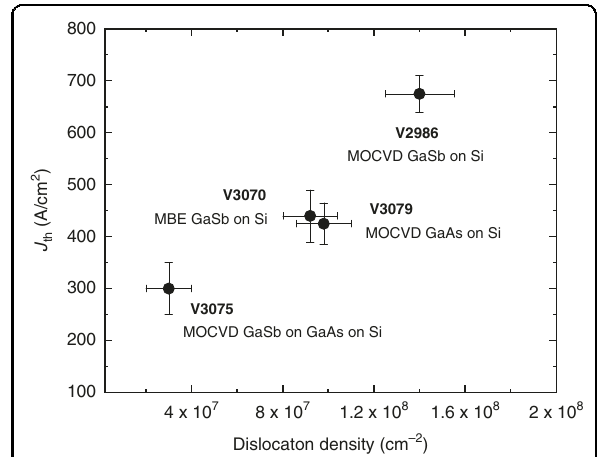
Fig. 11 Evolution of the threshold current density measured at room temperature for GaSb DLs grown on various III – V-on-Si templates, as a function of the threading dislocation density estimated by atomic force microscopy. The nature of the buffer layer is indicated next to the experimental data points